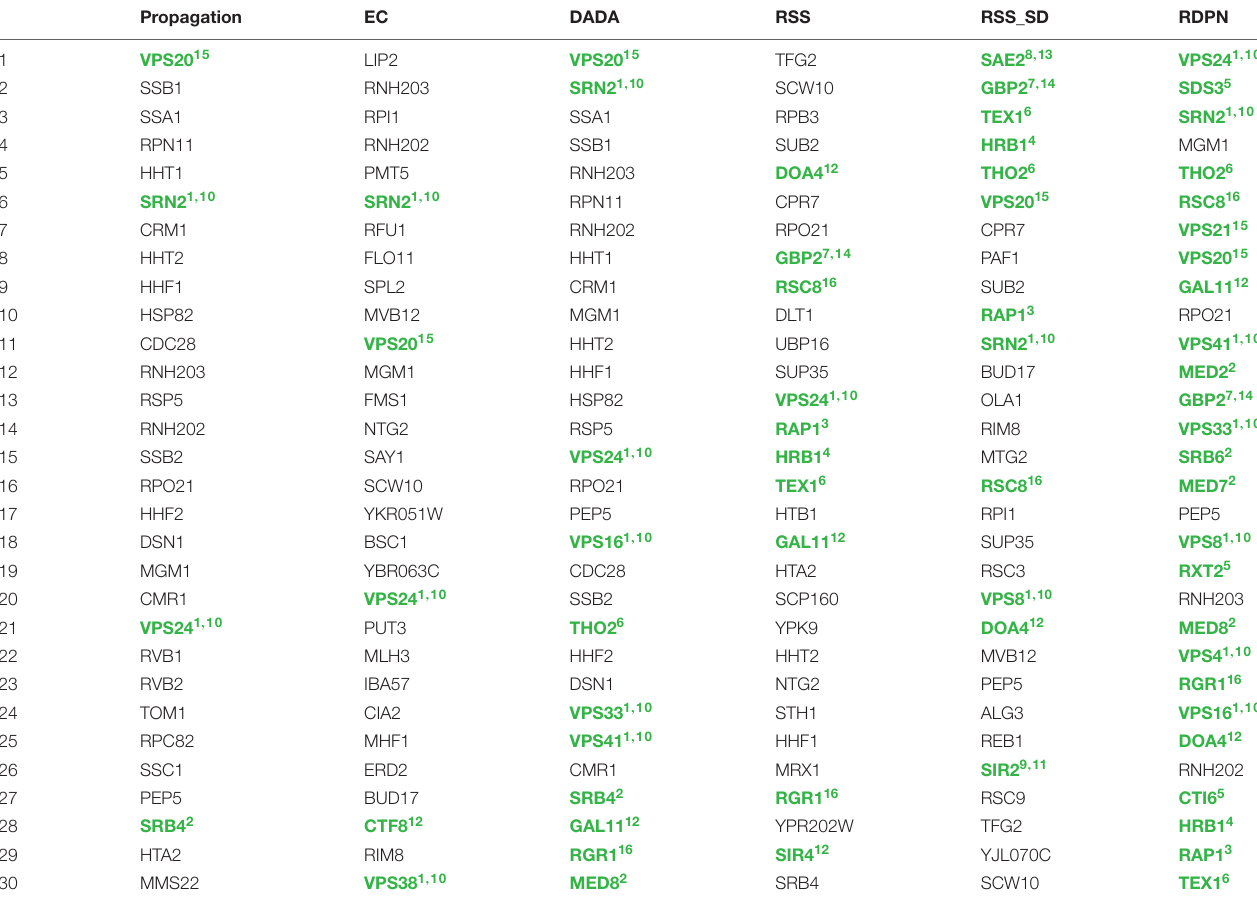
TABLE 2 | Top 30 proteins obtained by the different methods in the telomere-length maintenance case study.